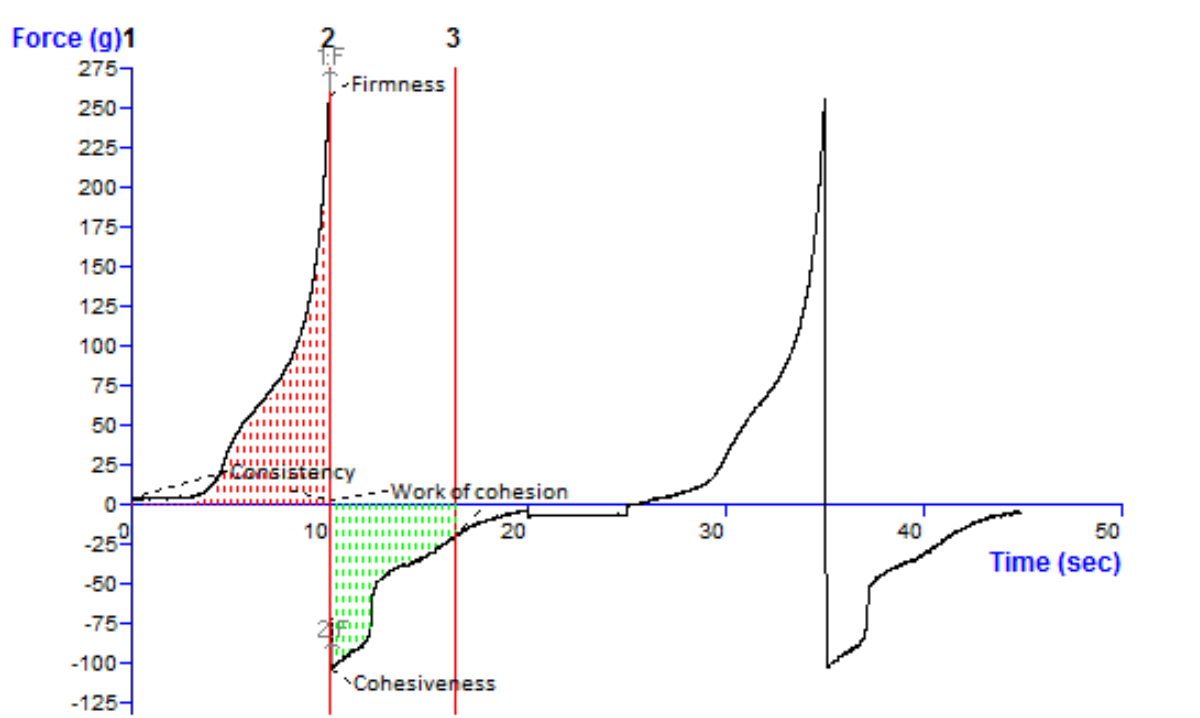
Figure 7. Texture analysis data of the TEFloaded ethosomal gel. The force-time plot was used to calculate parameters such as firmness, consistency, cohesiveness, and work of cohesion. The maximum positive force represents the hardness/firmness of the gel whereas cohesiveness is described as the negative area under the force-time curve. Table 8. Texture analysis data depicting the values of firmness, consistency, cohesiveness and work of cohesion of ethosomal gel.